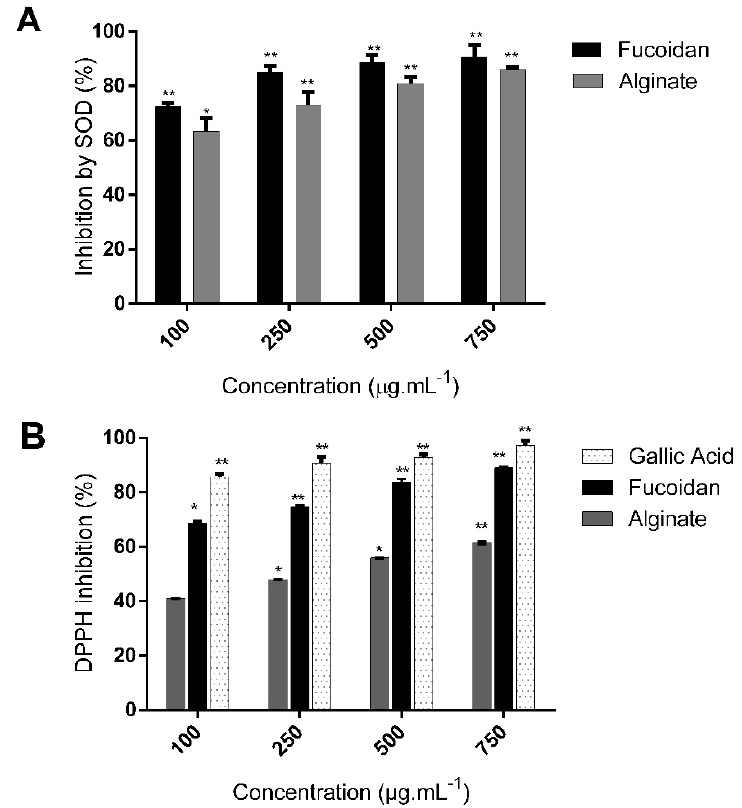
Figure 5. Antioxidant activity of C. sinuosa polysaccharides at four different concentrations (100–750 µg/mL −1 ) ( A ) Percentage inhibition of tetrazolium salts by SOD present in fucoidan and alginate ( B ) DPPH free radicals scavenging activity (% inhibition) of fucoidan and alginate (mean ± SD; n = 3). Significant differences are indicated as * p < 0.05 and ** p < 0.01 with respect to control.